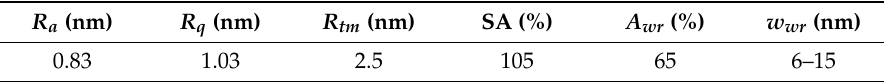
Table 1. The basic characteristics of the NC transferred graphene, determined from the AFM images. Roughness ( R a ), root-mean-square roughness, ( R q ), wrinkle height ( R tm ), surface area (SA), area covered with the wrinkles ( A wr ) and width, ( w wr ).